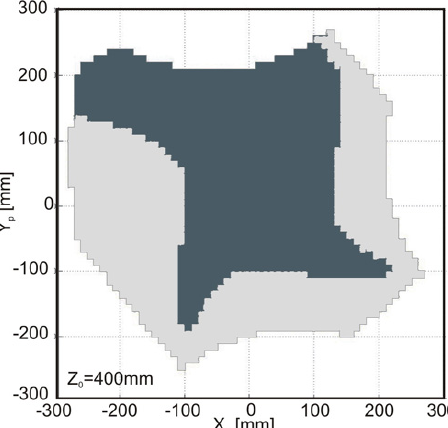
Figure 12. Successful grasp- and workspace area for linear motion (a) , circular motion (b) and circular motion with contact element modifications (c) .